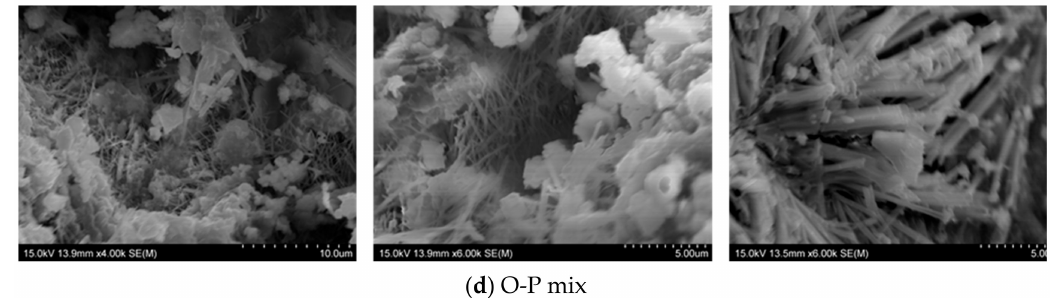
Figure 6. SEM micrographs of cementitious composites with and without CWA (taken from di ff erent locations) ( a ) O mix (Control) ( b ) O-K mix ( c ) O-X mix ( d ) O-P